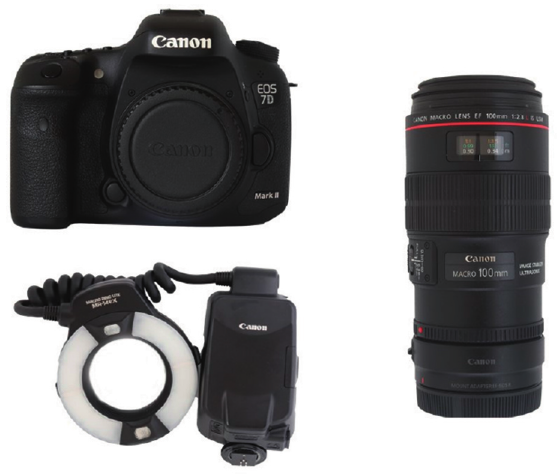
Figure 1: DSLR camera, macro lens and ring flash.